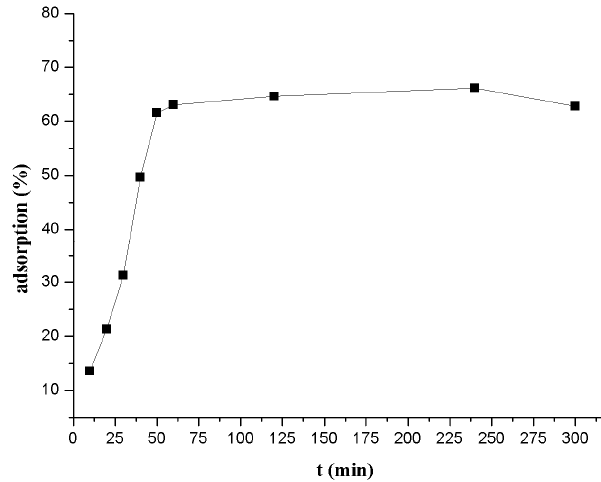
Figure 4. Effect of equilibrium time on Th(IV) adsorption onto β -CD(AN- co